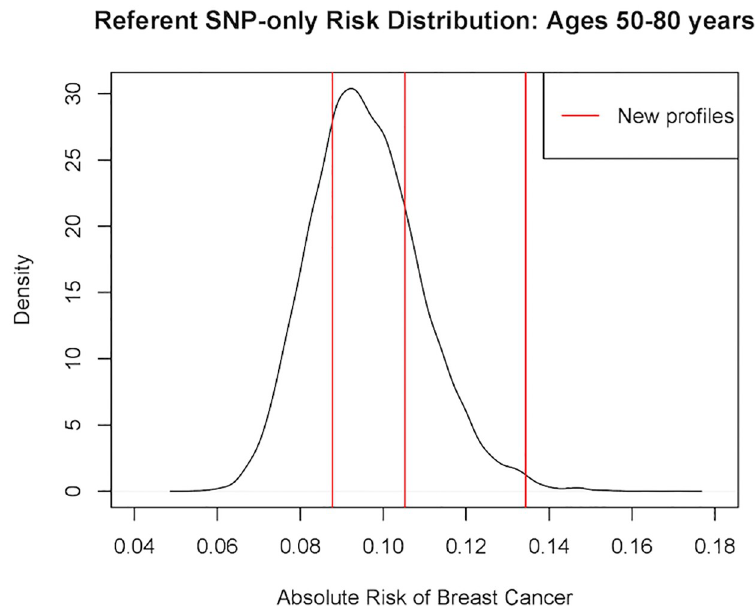
Fig 1. Estimated absolute risk of three women overlaid on the population distribution of absolute risk in the age interval: 50-80 years.